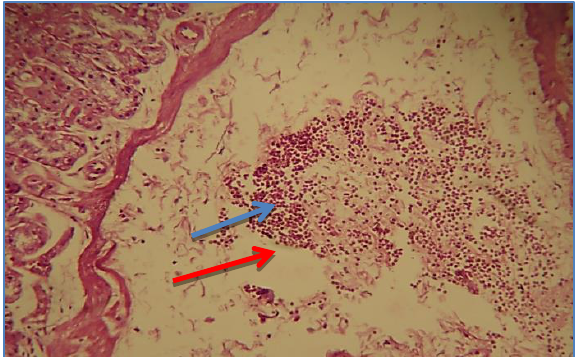
Figure, 9: Stomach of rabbit (G1), at 21st day p.o., showing sub mucosal edema (red arrow) with submucosal and subserosal hemorrhage (blue arrow) (H and E 40X).